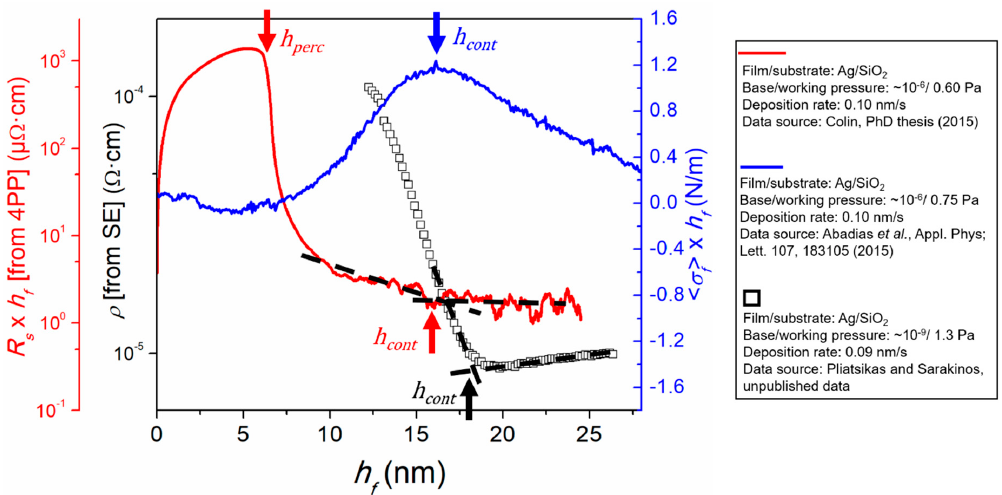
(cid:69) (cid:68) σ × h Figure 4. Evolution of resistivity ( ρ ∼ R s × h f ) and stress-thickness product Figure 4. Evolution of resistivity ( 𝜌~𝑅 (cid:3046) × ℎ (cid:3033) ) and stress-thickness product 〈𝜎 (cid:3033) 〉 × ℎ (cid:3033) vs. nominal film f f vs. nominal thickness ℎ (cid:3033) during growth of Ag on SiO 2 by magnetron sputtering, as measured from in situ and film thickness h f during growth of Ag on SiO 2 by magnetron sputtering, as measured from in situ real-time diagnostic tools: 𝑅 (cid:3046) (from four-point-probe measurements; red solid line; data taken from and real-time diagnostic tools: R s (from four-point-probe measurements; red solid line; data taken [105], 𝜌 (from spectroscopic ellipsometry (SE); hollow black squares; unpublished data by Pliatsikas from [105], ρ (from spectroscopic ellipsometry (SE); hollow black squares; unpublished data by Pliatsikas (cid:68) (cid:69) and Sarakinos), and 〈𝜎 (cid:3033) 〉 × ℎ (cid:3033) (from multiple-beam optical stress sensor (MOSS) measurements; data σ × h and Sarakinos), and f f (from multiple-beam optical stress sensor (MOSS) measurements; data taken from [73]). Growth conditions (deposition rate and base/working pressure) are indicated in the taken from [73]). Growth conditions (deposition rate and base / working pressure) are indicated in the corresponding legends, while all films have been grown at room temperature. The percolation ( ℎ (cid:3043)(cid:3032)(cid:3045)(cid:3030) ) corresponding legends, while all films have been grown at room temperature. The percolation ( h perc ) and continuous film formation ( ℎ (cid:3030)(cid:3042)(cid:3041)(cid:3047) ) thicknesses are determined by the curves as explained in the and continuous film formation ( h cont ) thicknesses are determined by the curves as explained in the text.